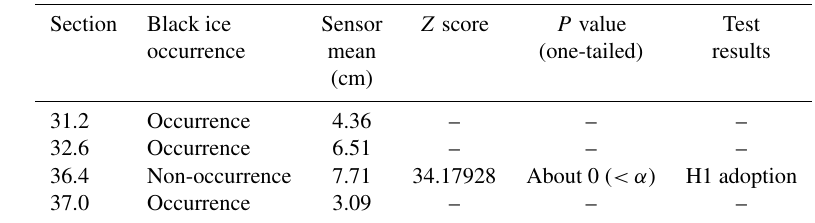
Table 7. Z -test (upper-tailed test) result of ultrasonic sensor data value.